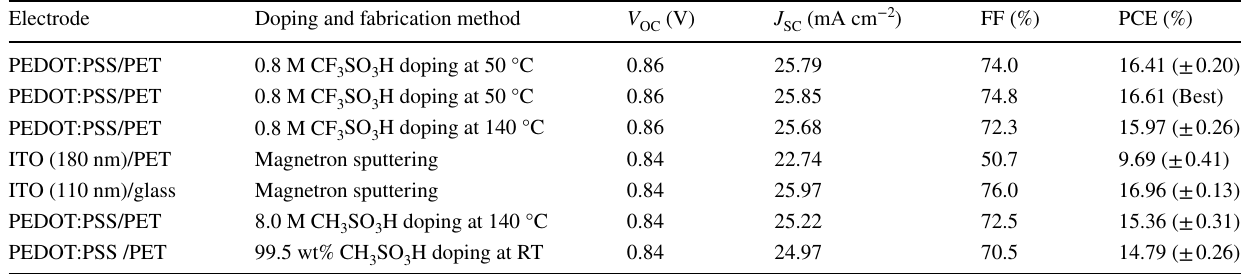
Over ten devices were reproduced to confirm the mean